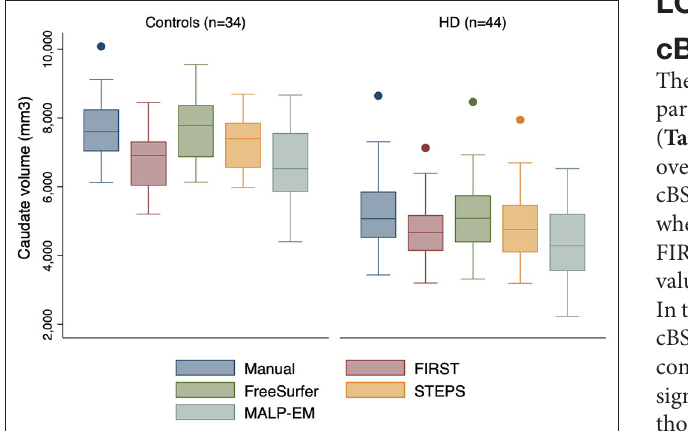
the other three sites (all p < 0.05) ( Supplementary Table 4 ).